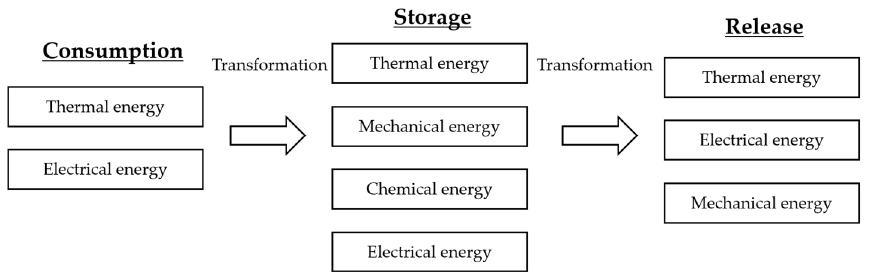
Figure 2. Energy transformation sequence of an accumulation system.